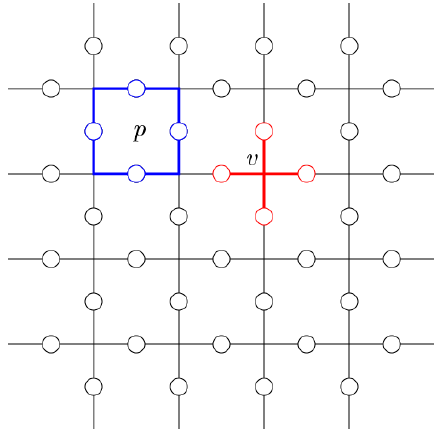
Figure 1: A system of spins on square lattice, plaquette and star are denoted respec- tively by p and v